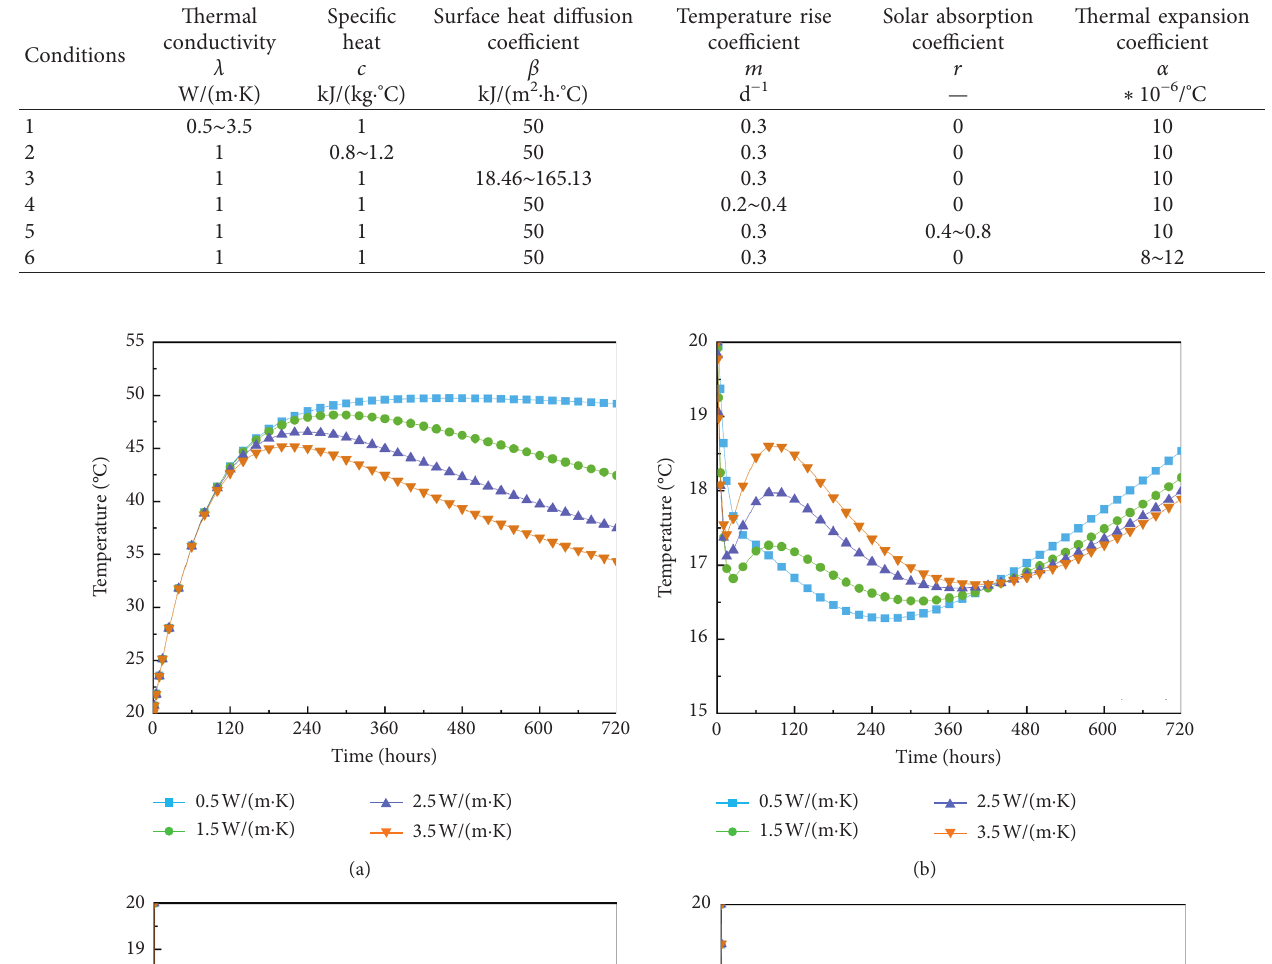
Table 2: Values of various thermal parameters under different conditions.